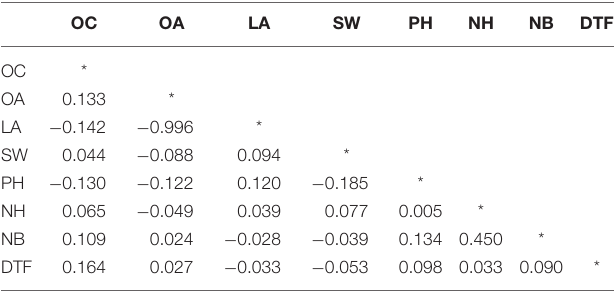
TABLE 2 | Correlation coefficient between eight quantitative traits studied in the entire safflower collection.